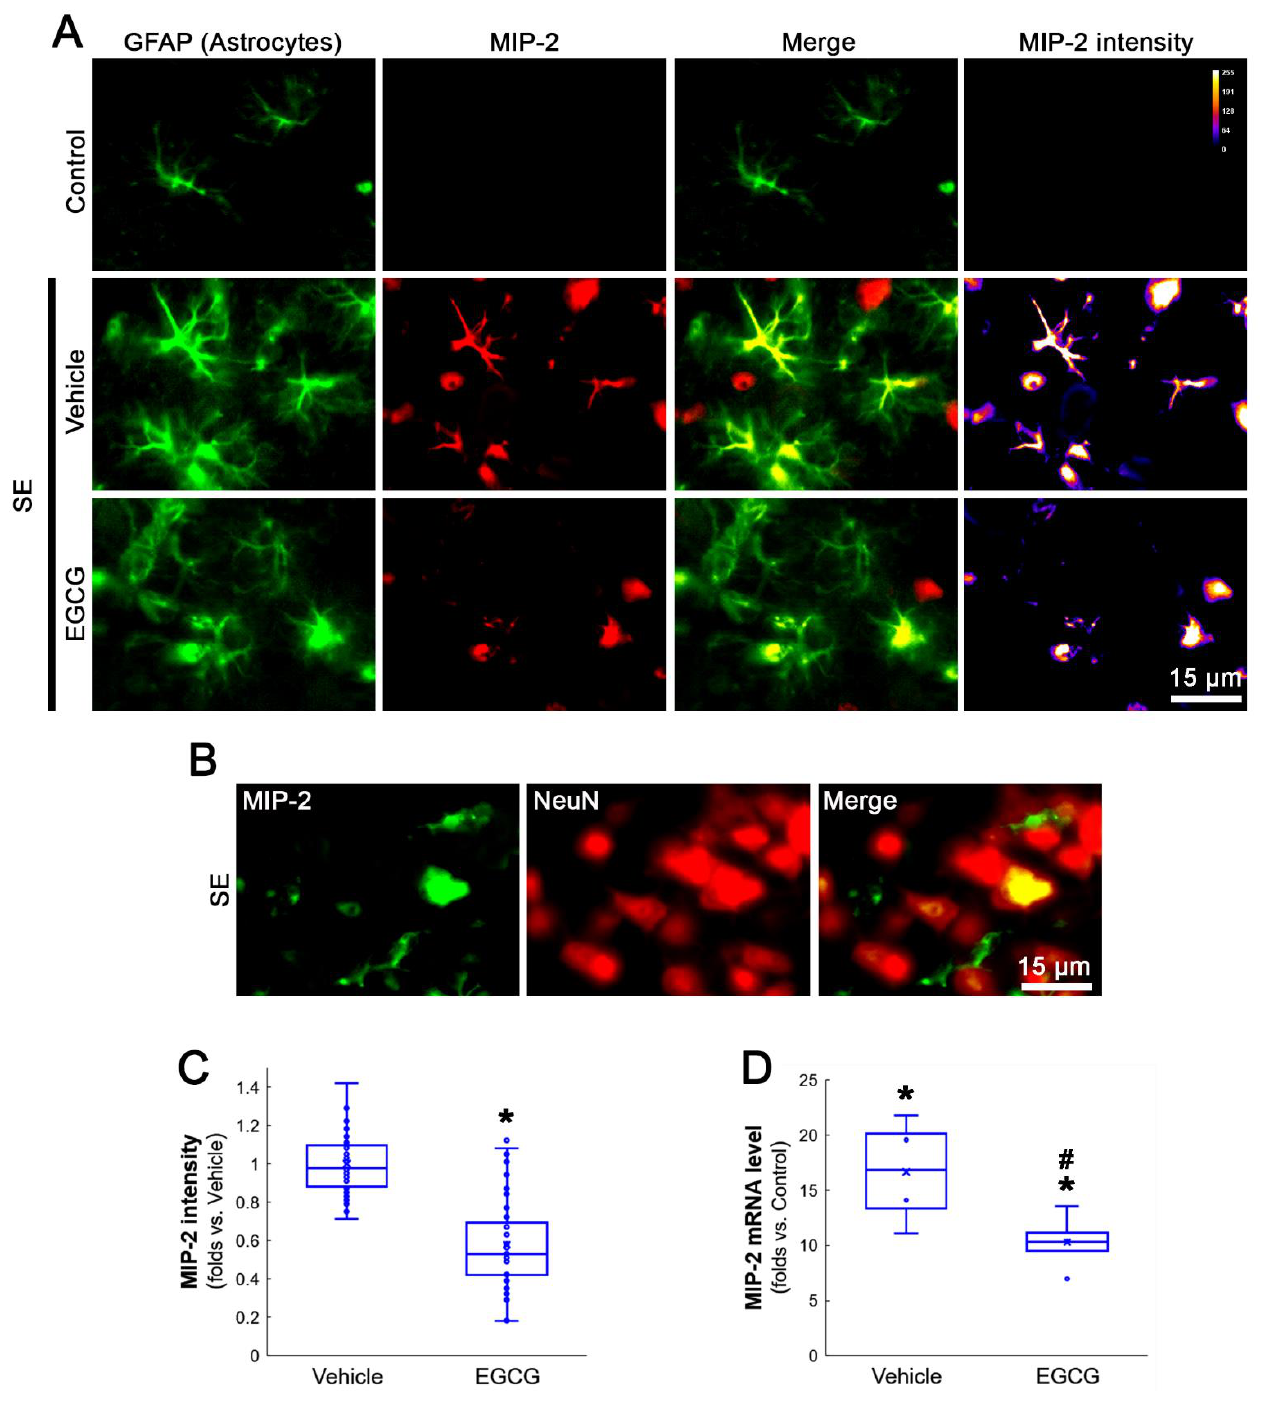
Figure 3. SE-induced MIP-2 induction and cellular localization of MIP-2. SE induces MIP-2 expression in reactive astrocytes and a few neurons. EGCG attenuates astroglial MIP-2 upregulation induced by SE. ( A ) Representative photos of astrocytes (GFAP), MIP-2 expression and MIP-2 intensity in the FPC. ( B ) Representative photos of CCR2 expression in a few neurons. ( C ) Quantification of the MIP-2 intensity in astrocytes. * p < 0.05 vs. vehicle ( n = 40 cells in 7 rats, respectively). ( D ) Quantification of the MIP-2 mRNA in the hippocampus. * ,# p < 0.05 vs. control animal and vehicle, respectively ( n = 4 rats, respectively).